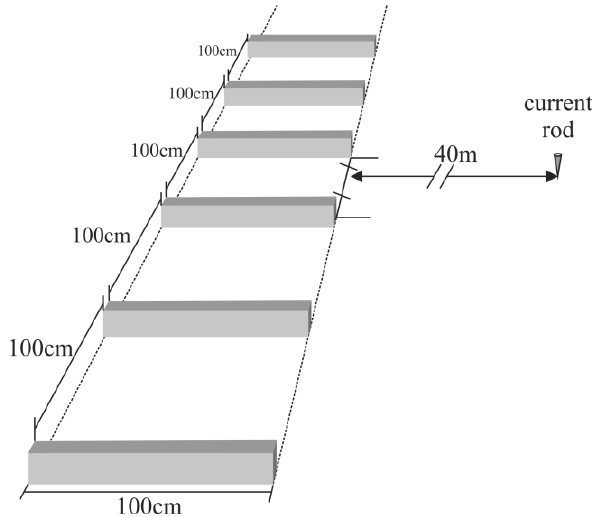
Fig. 2. Simplified disposition in soil of six different grounding grids